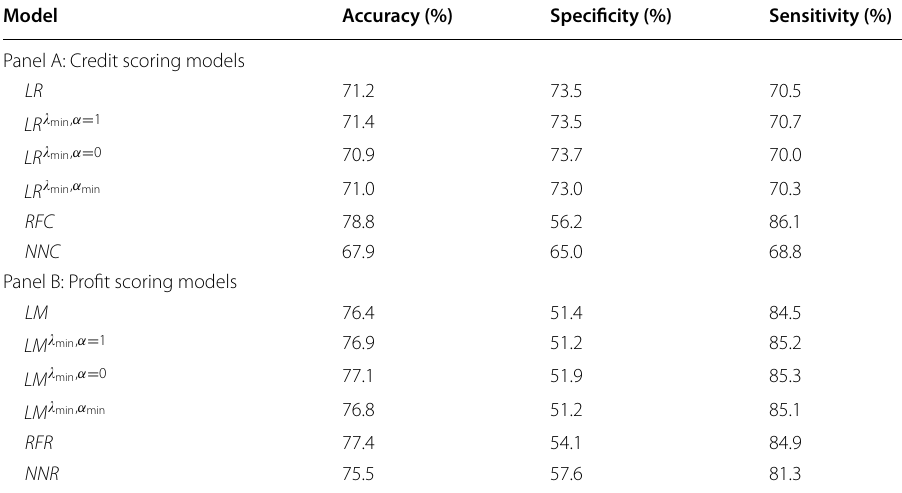
LR (cid:31) min , α = 1 , LR (cid:31) min , α = 0 , LR (cid:31) min , α min are lasso, ridge and elastic net version of logistic regression, LM (cid:31) min , α = 1 , LM (cid:31) min , α = 0 , LM (cid:31) min , α min are lasso, ridge and elastic net version of linear regression RFC random forest classification, NNC neural network classification, RRR random forest regression, NNR neural network regression